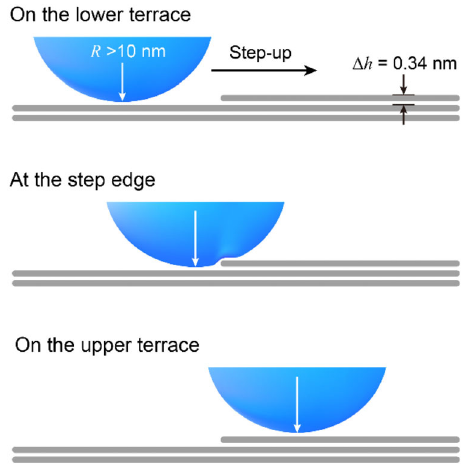
Fig. 4 Illustrations of an AFM tip slides across an exposed graphene step edge. The leading edge of the AFM tip elastically deforms when the AFM tip is at the graphene step edge. Note that the image is not in scale; the actual height of the step edge (  h ) is much smaller than the radius ( R ) of the tip. The white arrow is the center axis of the AFM